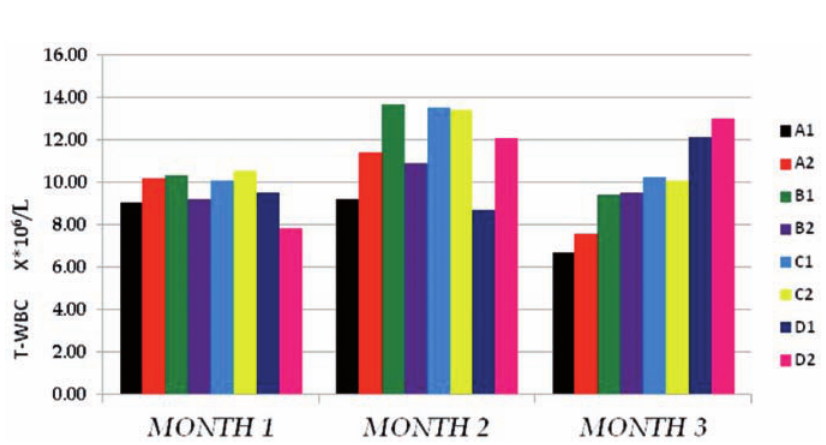
Figure 1. The total white blood cells count (T-WBC ¥ 10 6 /L) mean values of the different subgroups for the 3 months study period.